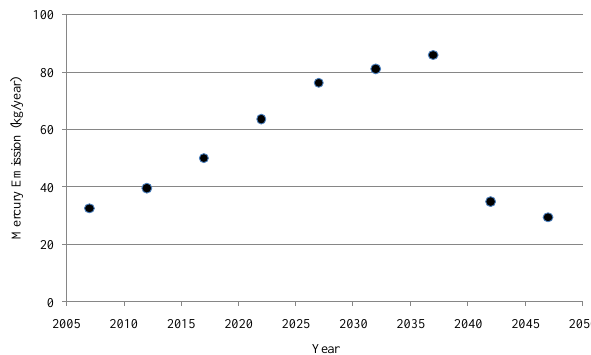
Fig. 6. Estimated future trends of total mercury emissions in Japan Figure 6. Estimated future trends of total mercury emissions in Japan from crematories from crematories based on population demographic statistics and based on population demographic statistics and measured data. measured